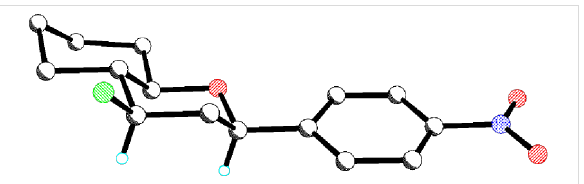
Figure 2: X-ray crystal structure of the major bicyclic tetrahydropyran diastereoisomer 9b